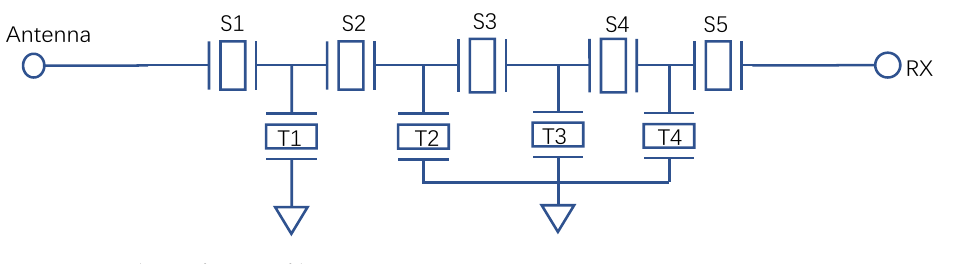
Figure 8. Topology of a SAW filter.